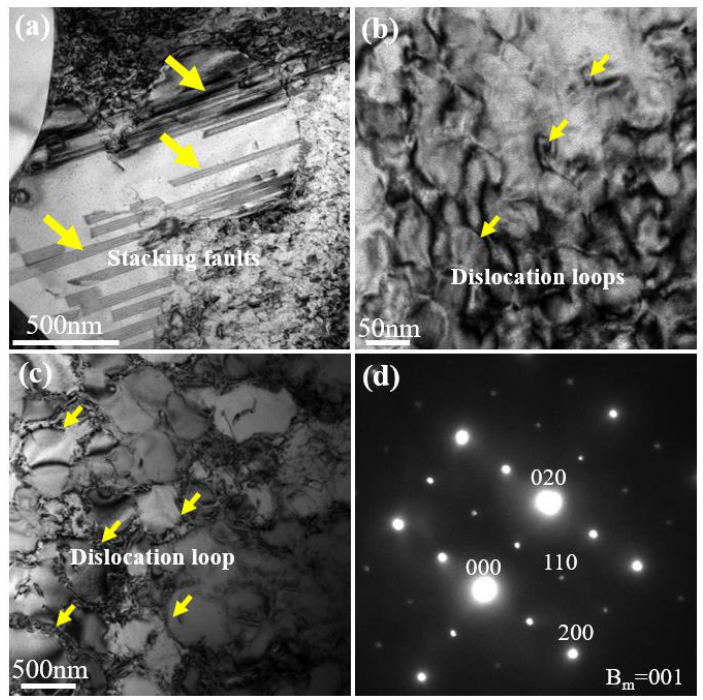
Figure 7. Deformed microstructures after tensile testing at 850 °C and 900 °C: ( a , b ), 850 °C; ( c , d ), 900 °C.